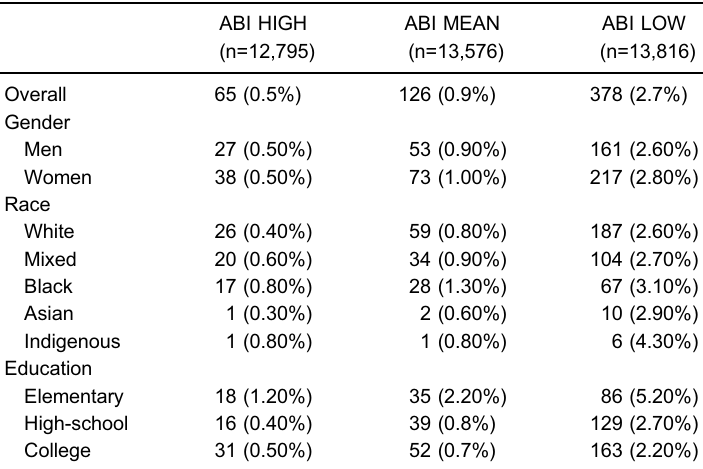
Table 1. Sociodemographic characteristics of the three categories obtained by using different methods of calculating ankle-brachial index (ABI) at baseline in the ELSA-Brasil study participants (2008 –